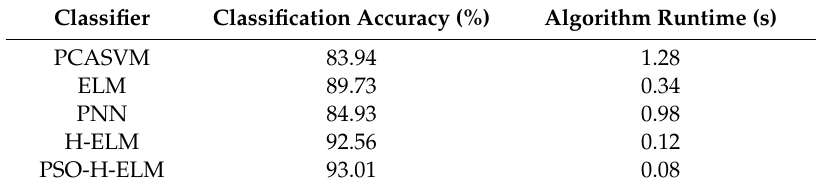
Table 8. Comparison of classification accuracy and algorithm running time of five methods.